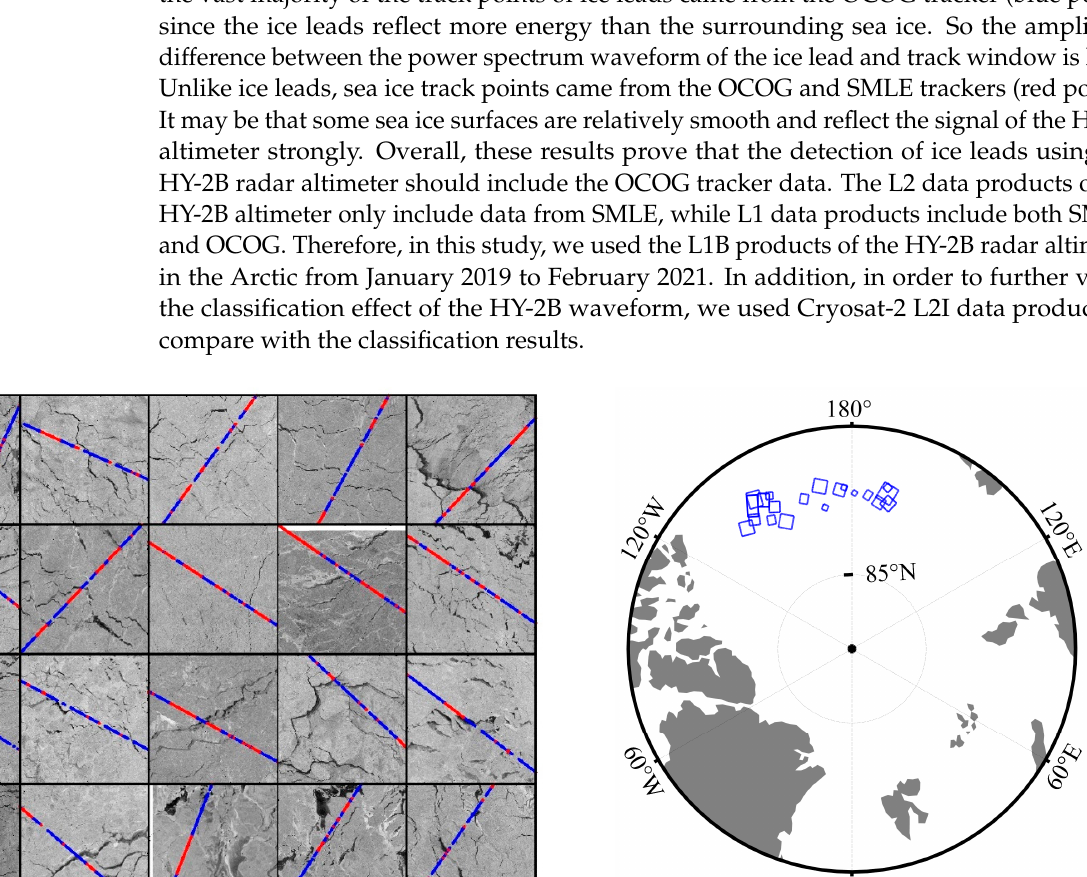
Figure 1. The percentage of OCOG and SMLE tracking model data: ( a ) OCOG; ( b ) SMLE.